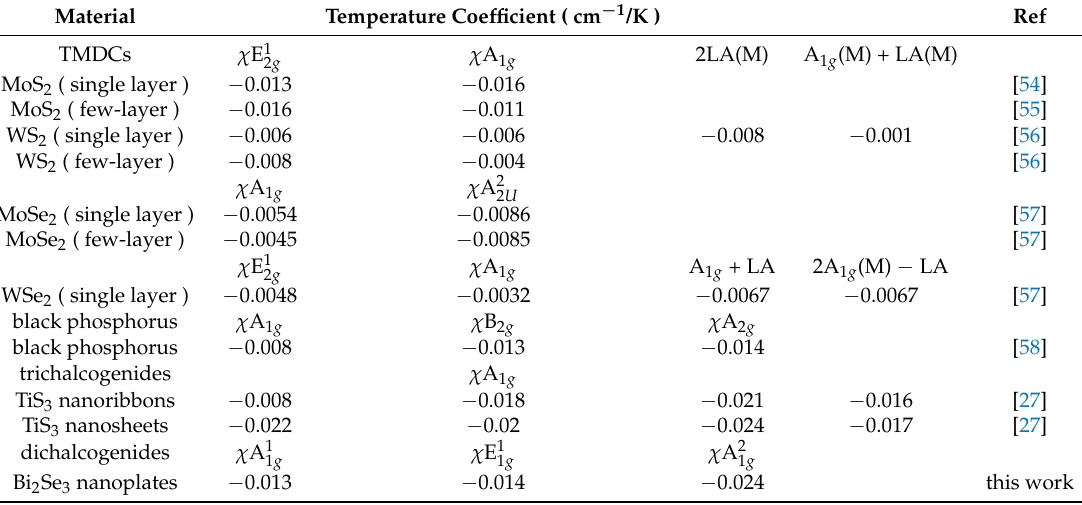
Table 2. The first-order temperature coefficient for the different Raman modes of other two-dimensional